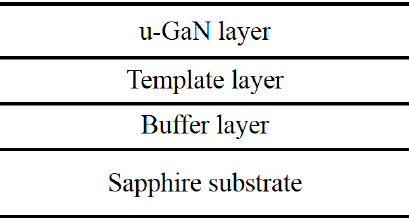
Figure 1. Schematic diagram of the epitaxial structure of u-GaN samples.